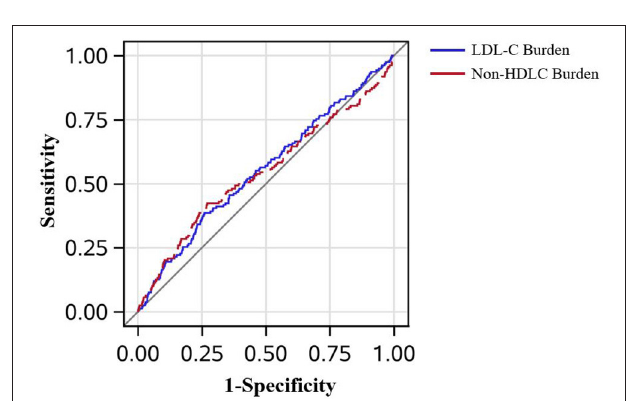
FIGURE 4 | The receiver operating characteristic curves in all patients. The low-density lipoprotein cholesterol burden had the tendency to perform better than the non-high-density lipoprotein cholesterol burden in predicting peripheral artery disease after adjustment for age, sex, smoker, drinker, body mass index, diabetes mellitus, hypertension, hypercholesterolemia, physical activity, and income status (0.554 vs . 0.544, P =